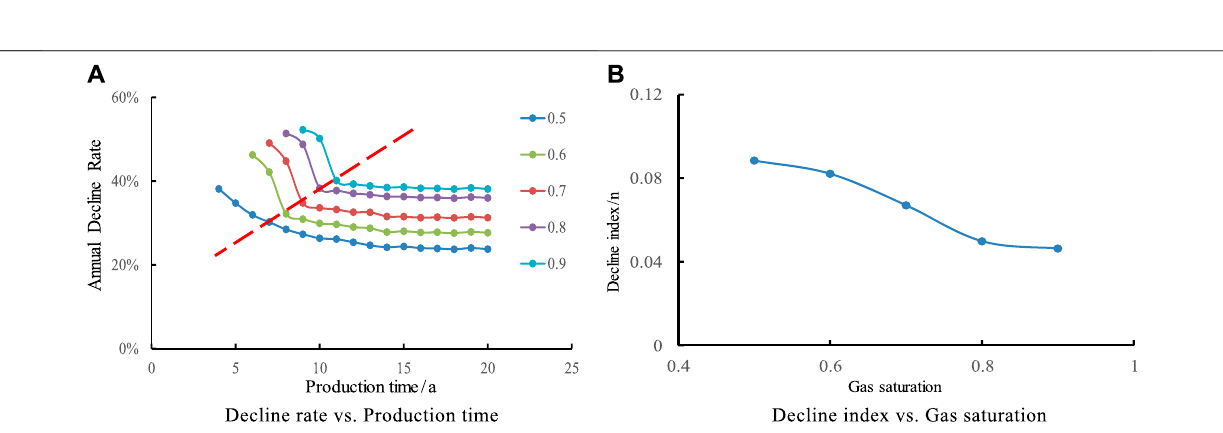
FIGURE 2 | Effect of porosity on Annual Decline Rate and decline index. (A) Decline rate vs. Production time. (B) Decline index vs. Porosity.